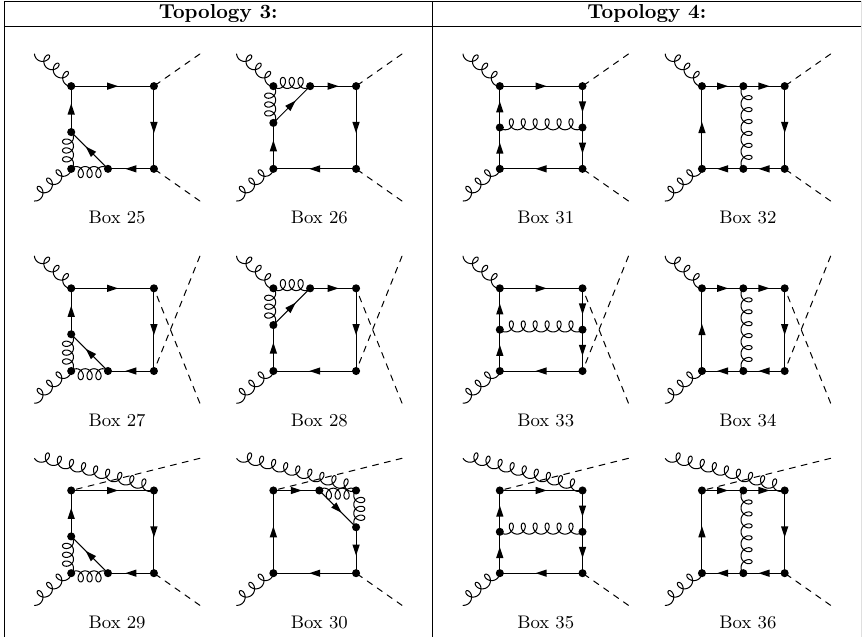
Figure 20 . Two-loop box diagrams: topologies 3 and 4.